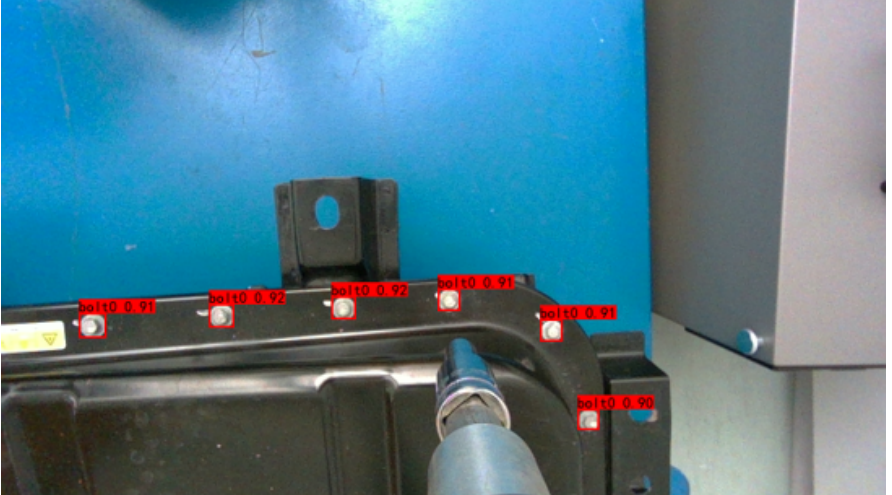
Figure 18. Screw positioning results based on images collected after attitude correction by robotic arm.